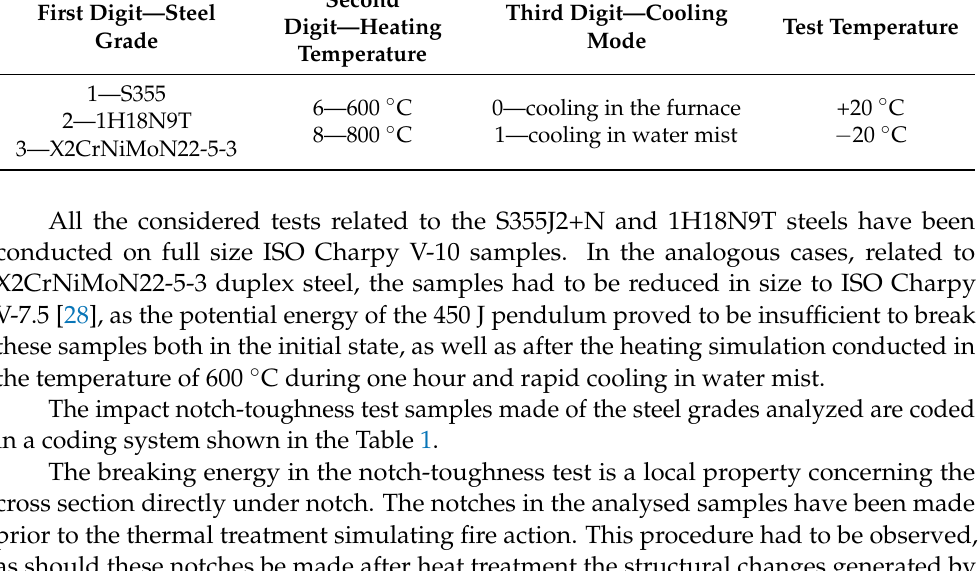
Figure 6. Measurement device used to measure the longitudinal expansion LE .